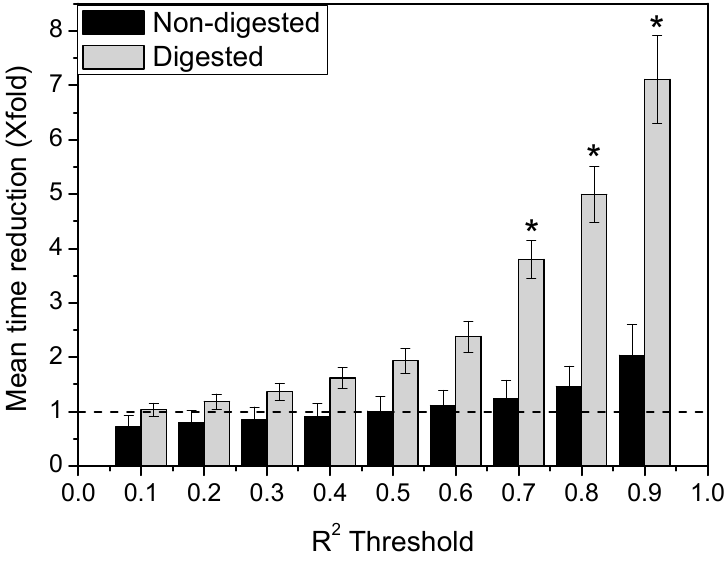
Figure 7. Reduction on the mean time required by non-digested (black columns) and digested (grey columns) lipid nanocarriers to diffuse across an intestinal porcine mucus layer of 100 µm based on a single ( R 2 ) or combination ( R 2 + RSS ) screening approach (dotted line) (* p < 0.05).